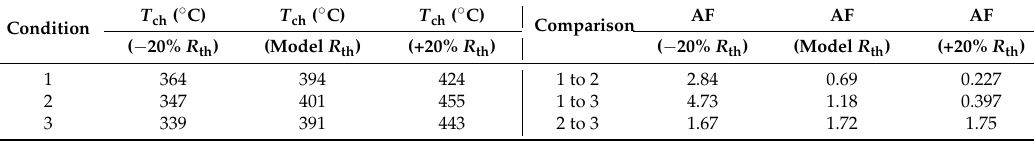
Table 3. Sensitivity analysis of thermal model for R th for Conditions 1, 2, and 3.